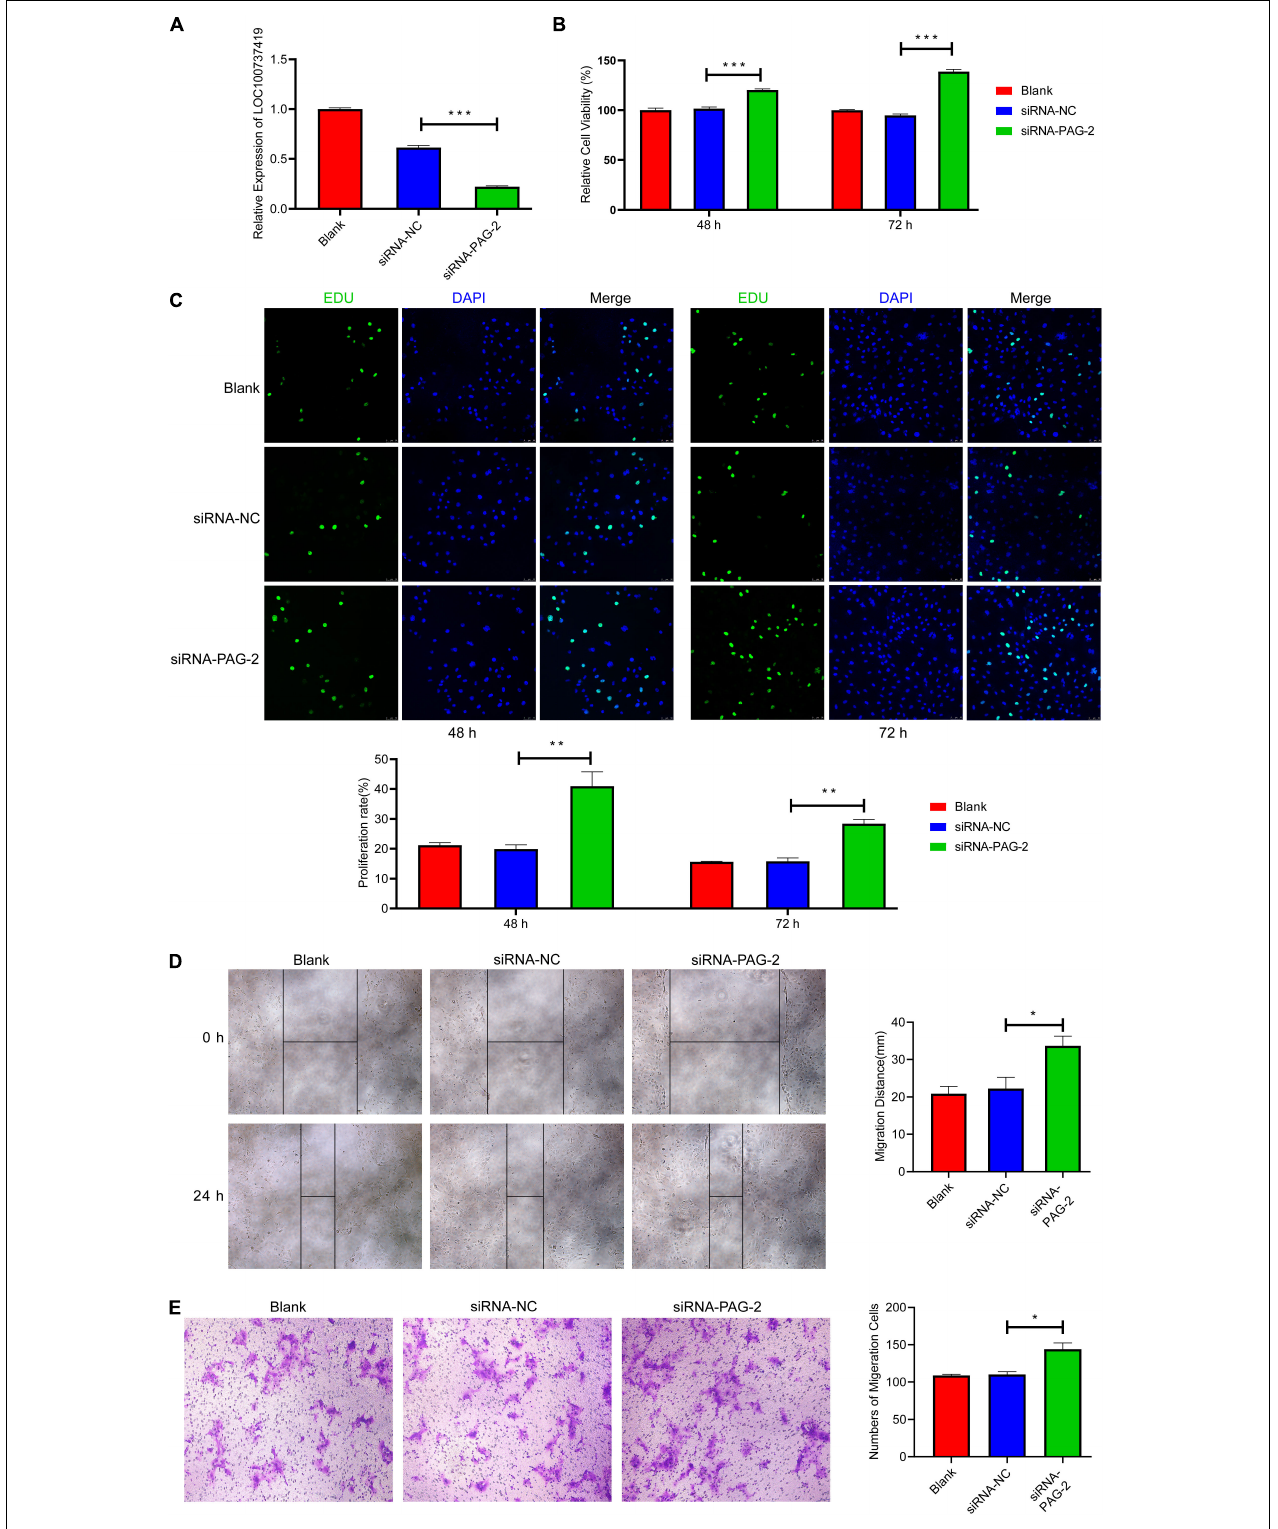
FIGURE 8 | Knockdown of PAG-2 promotes cell proliferation and migration in vitro . (A) Transfection efficiency of PAG-2 siRNA was determined by PCR. (B) The cell viability of PTr2 cells was applied by CCK-8 assay. (C) EDU staining assay was performed to determine the cell proliferation changes after PAG-2 knockdown. (D) Wound healing assay for the evaluation of migration of PTr2 cells. (E) Transwell migration assay showed that knockdown PAG-2 increased the cell numbers of migration. CCK8, Cell Counting Kit-8. Data are presented as mean ± SEM. * P < 0.05, ** P < 0.01, *** P < 0.001, and Student’s t -test.